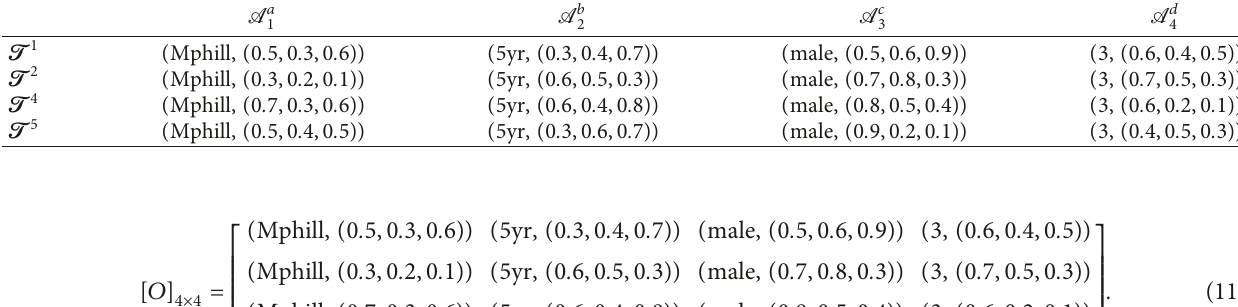
Table 4: Decision makers will assign neutrosophic numbers to each candidate T